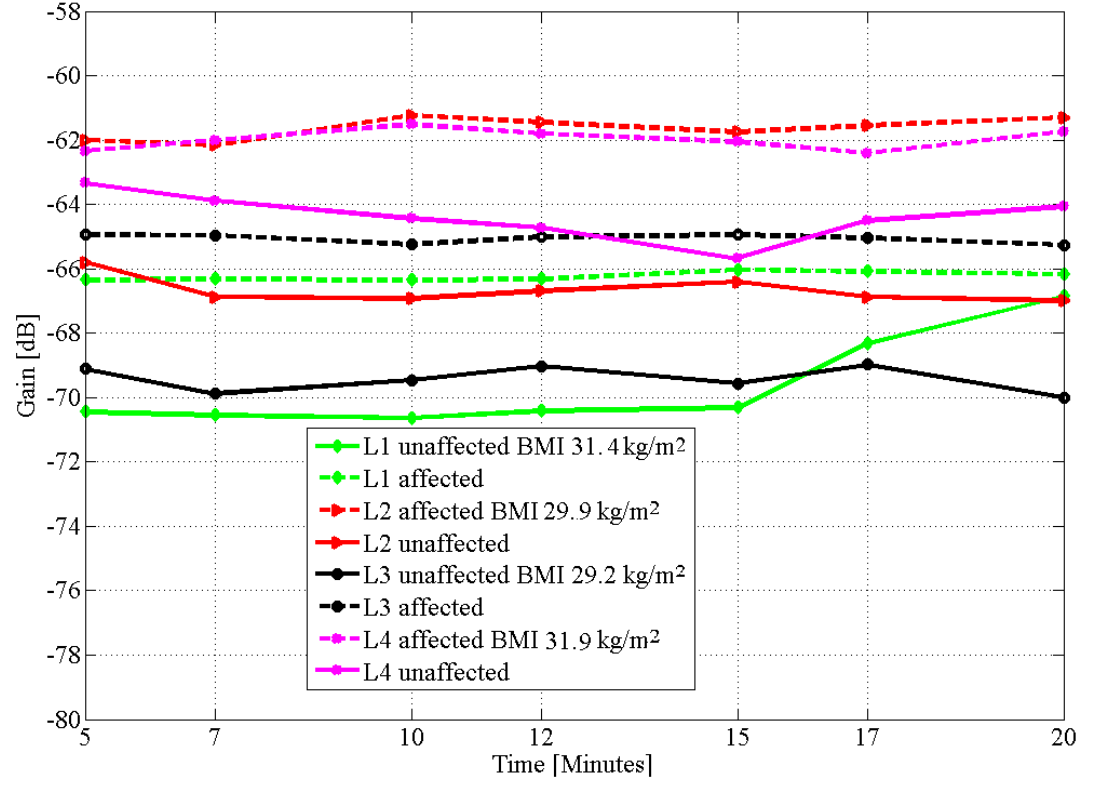
Figure 5. Measurement of galvanic coupled signal gain at 900 kHz, after fluid restriction and intake of 350 mL, on both arms of lymphoedema affected